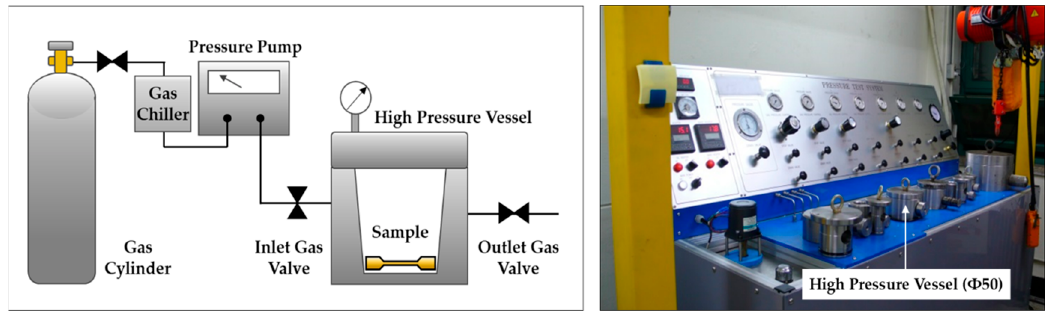
Figure 1. Batch microcellular foaming process (MCP) adopted in this study ( left ) and batch processing equipment used in the experiment ( right ).